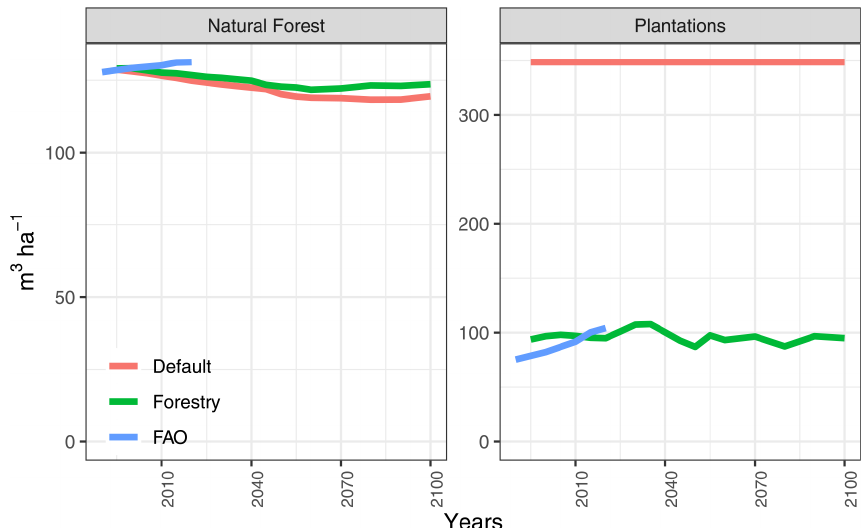
Figure 8. Global growing stock in natural forests and plantations between 1995 and 2100 (in m 3 ha − 1 ). Historical values are taken from FAO